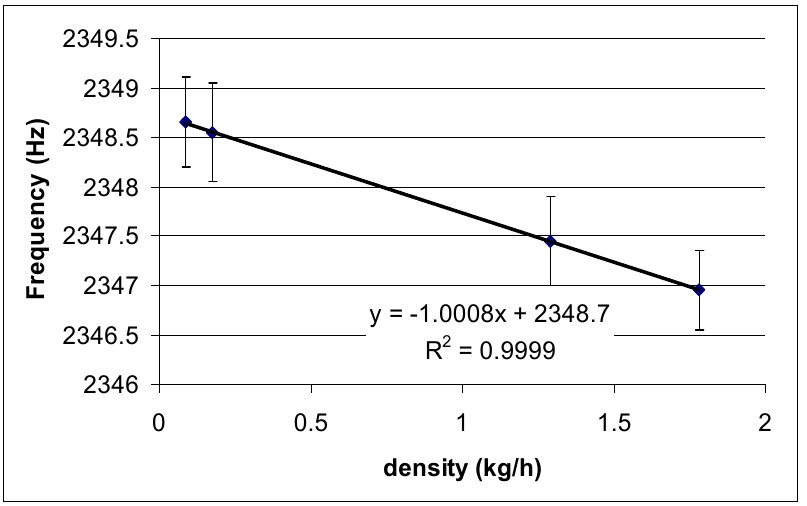
Figure 12. Measured resonance frequency for different gases (Table 1). The error bars represent the minimal and maximal deviation from the average measured in